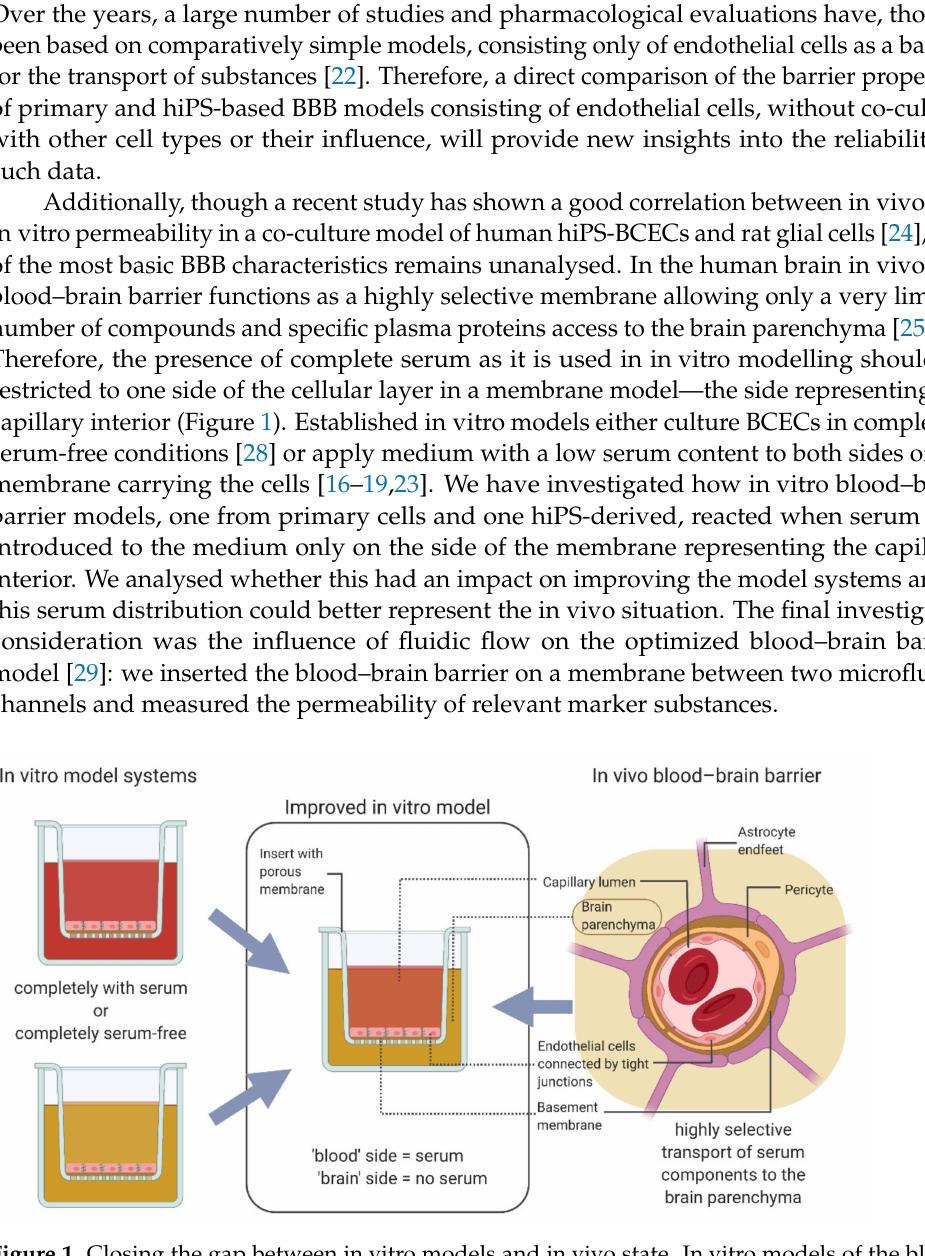
Figure 1. Closing the gap between in vitro models and in vivo state. In vitro models of the blood– brain barrier (BBB) are cultured with identical media on both sides of the cellular layer, either with serum or under completely serum-free conditions. In vivo, the BBB utilises highly selective transport mechanisms to regulate the nature and amount of serum components allowed to cross into the brain parenchyma. Applying this understanding to the culture conditions of an in vitro model system reveals a simple but important step towards more closely modelling this situation: medium containing serum is applied to the “blood” side of the cellular layer; medium without serum is applied to the “brain” side. Created with